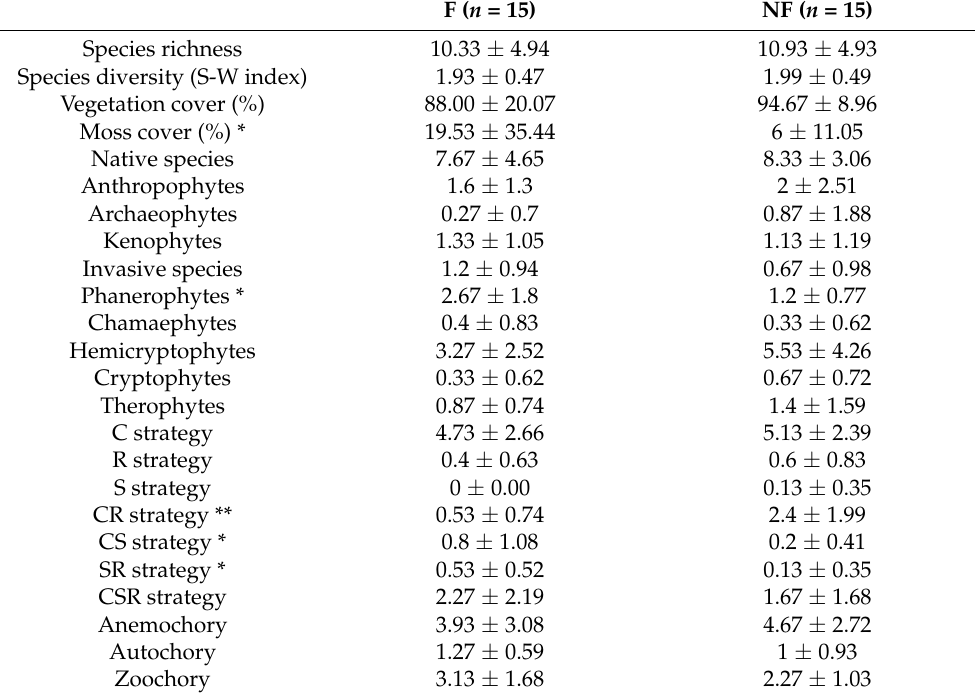
Table 3. Flora and vegetation properties on the investigated plots (means and standard deviations). The statistical differences between means were marked by the asterisk next to the name of the variable according to the Mann–Whitney U test (*— p ≤ 0.05; **— p ≤ 0.01). For explanations of life forms, see section Materials and Methods (subsection: